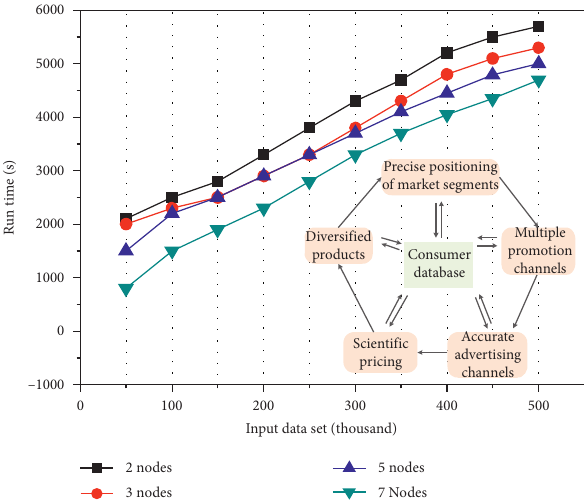
Figure 6: The specific process of precision marketing and the test results of recommendation